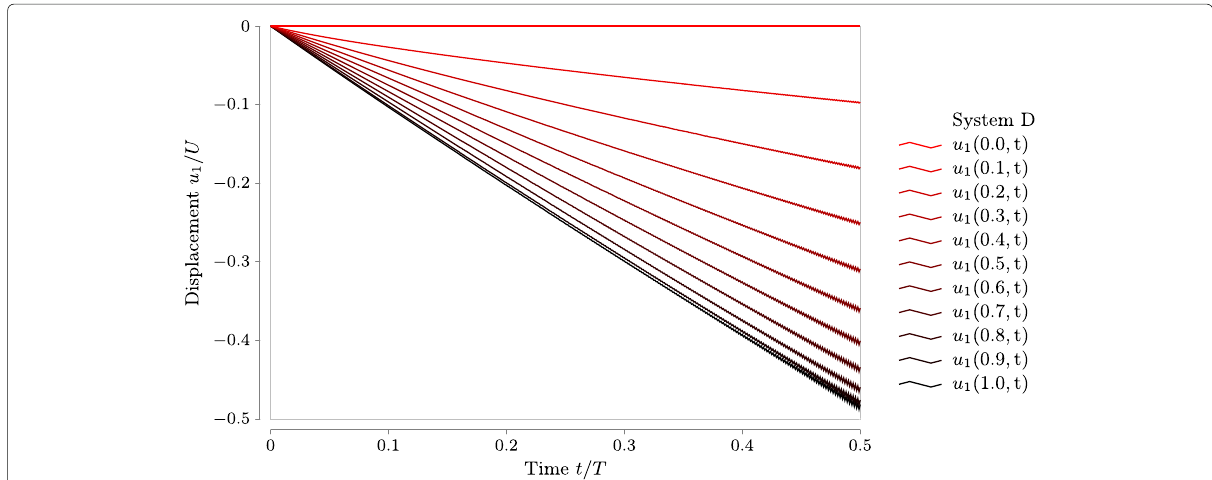
Fig. 6 MATLAB simulation of u 1 ( z , t ) for z ∈ { 0,0.1, ... ,0.9,1 } for A 1 = A 2 = 0 and the other parameters with the values of Table 1. The oscillations in the graphs are due to an unphysical alternating-in-time solution of v 3 ( z , t ) in the MATLAB